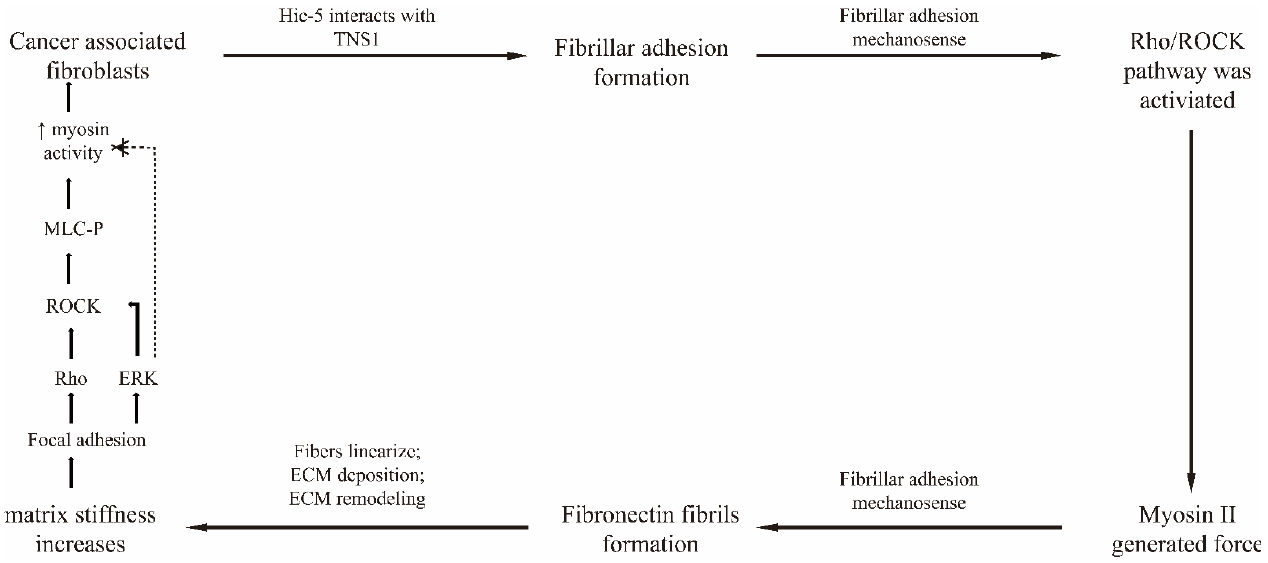
Figure 5. Mechanisms affecting tumor disease progression through mechano-transduction in tumor-associated fibroblasts.